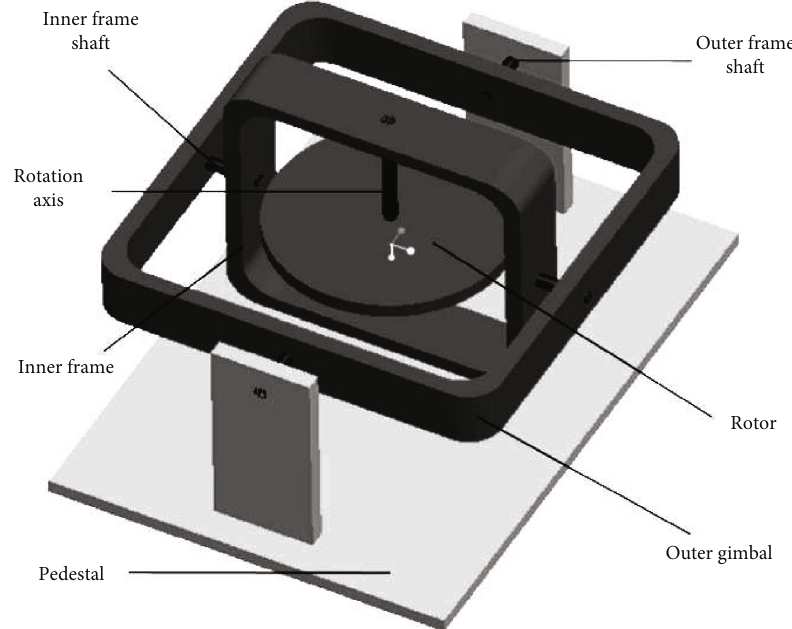
Figure 3: Structural diagram of two degree of freedom gyroscope